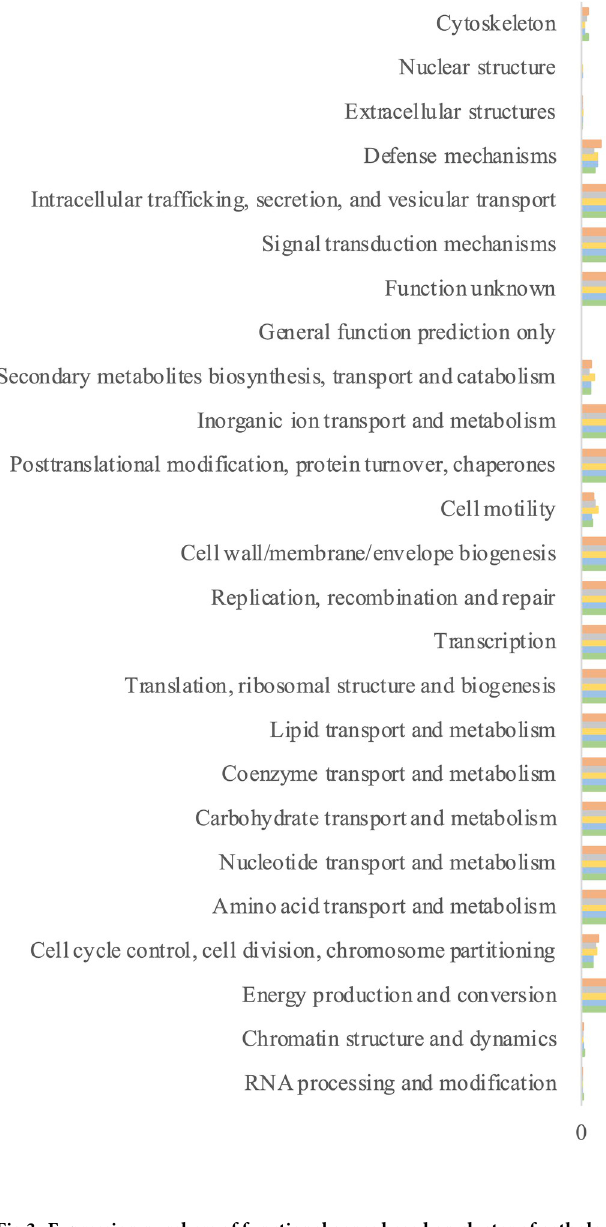
PLOS ONE | https://doi.org/10.1371/journal.pone.0258663 October 21,